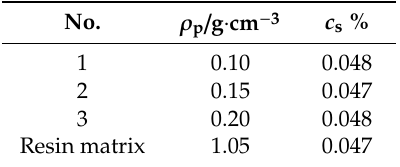
Table 4. Water absorption of polyurethane resin matrix and composites.